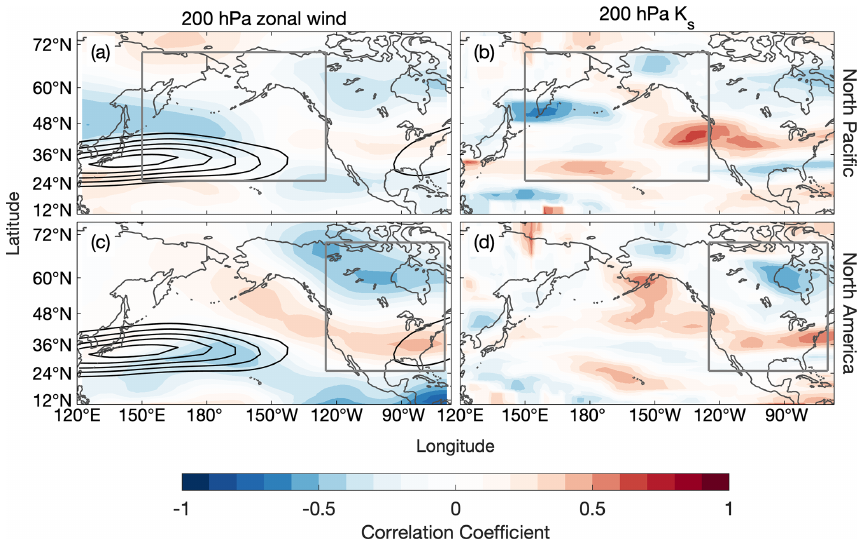
Figure 6. Correlation coefficient between the local change in the 200hPa zonal wind and the regional mean change in the teleconnection amplitude over (a) the North Pacific and (c) North America. Correlation coefficient between the local change in the stationary Rossby wave number, K s , and the regional mean change in the teleconnection amplitude over (b) the North Pacific and (d) North America. Grey boxes outline the North Pacific and North America